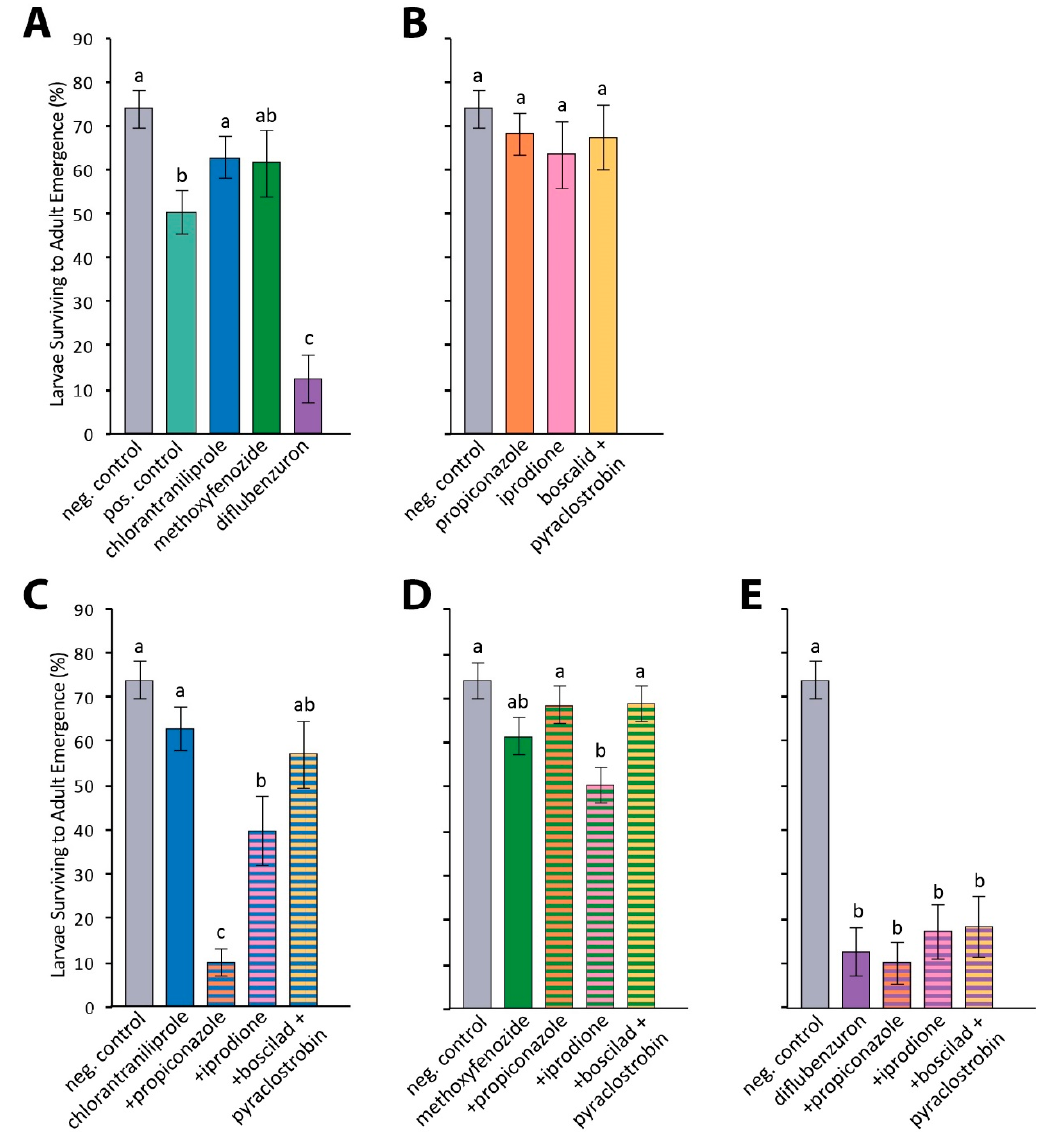
Effects of insecticides, fungicides, and combination treatments on larval survival. Average percent larvae surviving to adult emergence is shown, with error bars displaying standard error. Treatments with different letters indicate significantly different levels of adult emergence ( p < 0.05). Negative solvent control (N = 130) and insecticide-only results are reproduced across subplots. ( A ) Insecticide treatments (dimethoate positive control N = 130; chlorantraniliprole N = 131; methoxyfenozide N = 114; diflubenzuron N = 63); ( B ) fungicide treatments (propiconazole N = 63; iprodione N = 47; boscalid and pyraclostrobin N = 47); ( C ) chlorantraniliprole combination treatments (+propiconazole N = 146; +iprodione N = 48; +boscalid and pyraclostrobin N = 63); ( D ) methoxyfenozide combination treatments (+propiconazole N = 79; +iprodione N = 63; +boscalid + pyraclostrobin N = 63); and (E) diflubenzuron combination treatments (+propiconazole N = 63; +iprodione N = 63; +boscalid and pyraclostrobin N = 47).